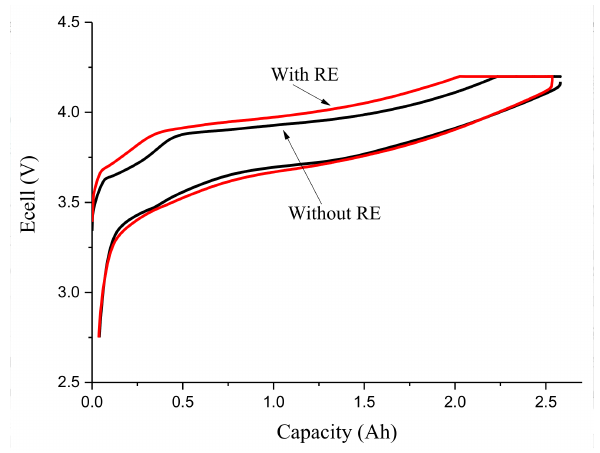
Figure 4. Cell voltage vs. capacity during multiple charge/discharge cycles for the same cell with (red curve) and without (black curve) the RE inserted.